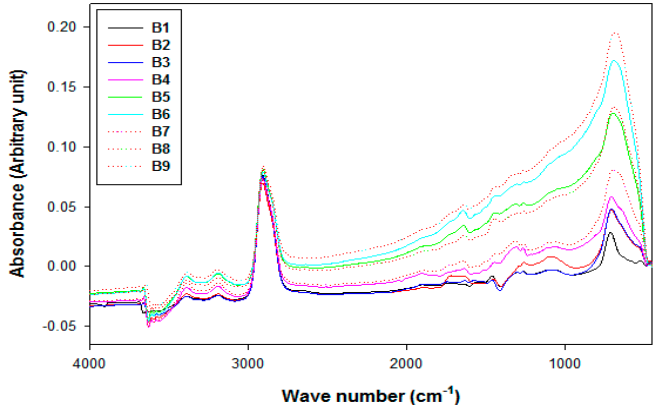
Figure 4. Fourier transform infrared (FTIR) spectra of LDPE and its composite films.